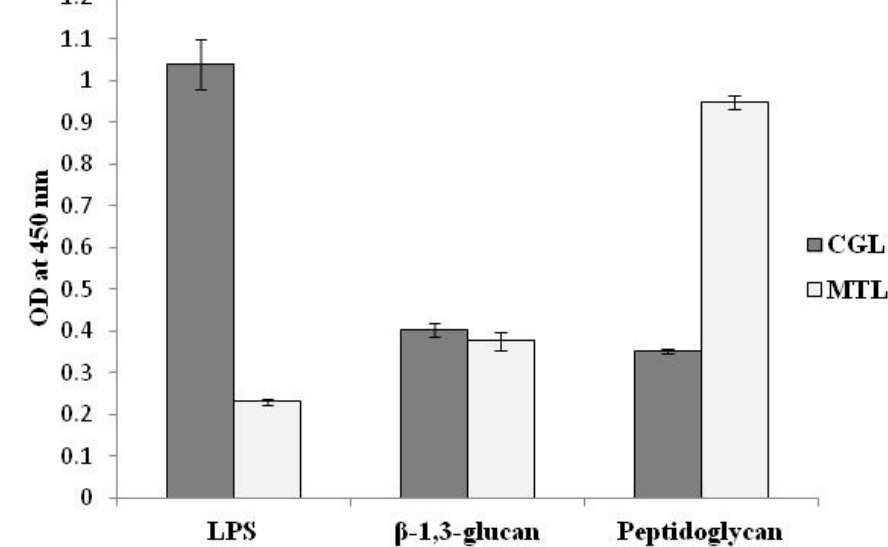
Figure 2. The binding activity of lectins with PAMPs determined by ELLA. Microtiter plates were coated with PAMPs (50 µg/mL, LPS from Escherichia coli , β -1,3-glucan from Euglena gracilis , PGN from Staphylococcu aureus ), followed by an incubation with a conjugate of HRP-labeled CGL and MTL at concentrations from 10 to 0.156 mg/mL. The ELLA data are expressed as mean ± SD of three separate experiments.